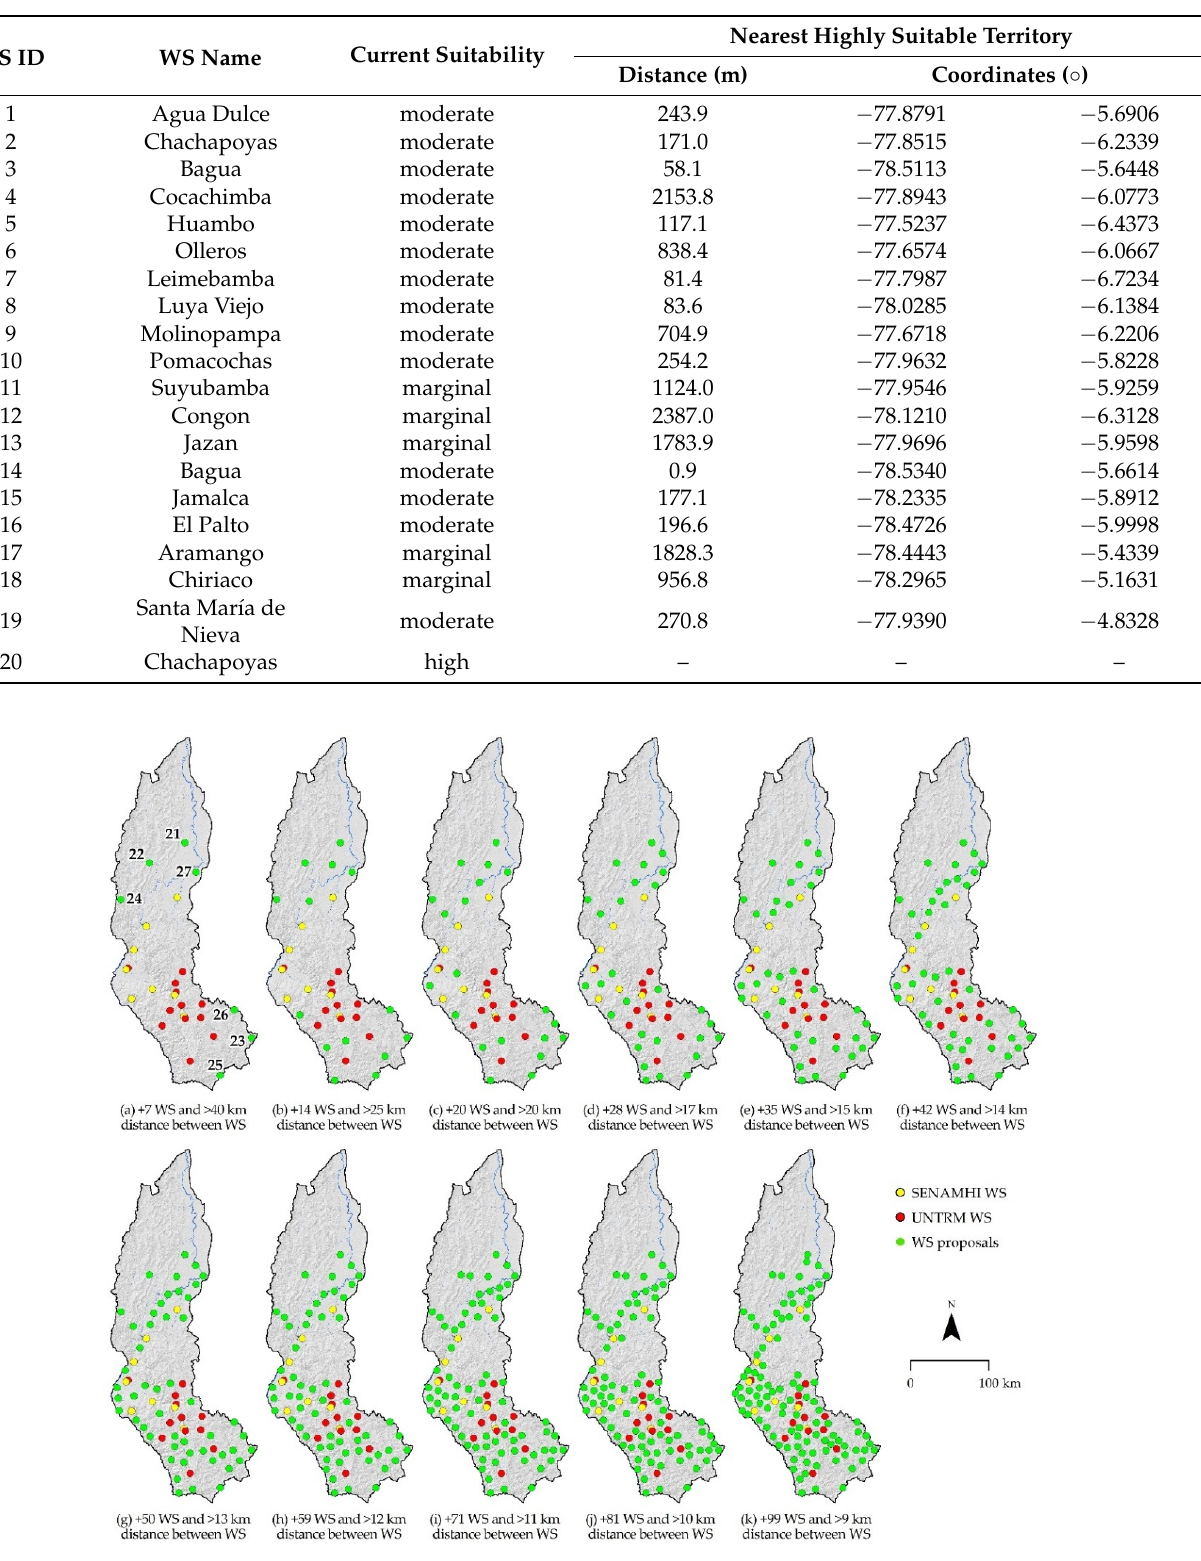
Table 7. Suitability of the existing WS sites and very suitable locations closer to them in Amazonas, NE Peru.